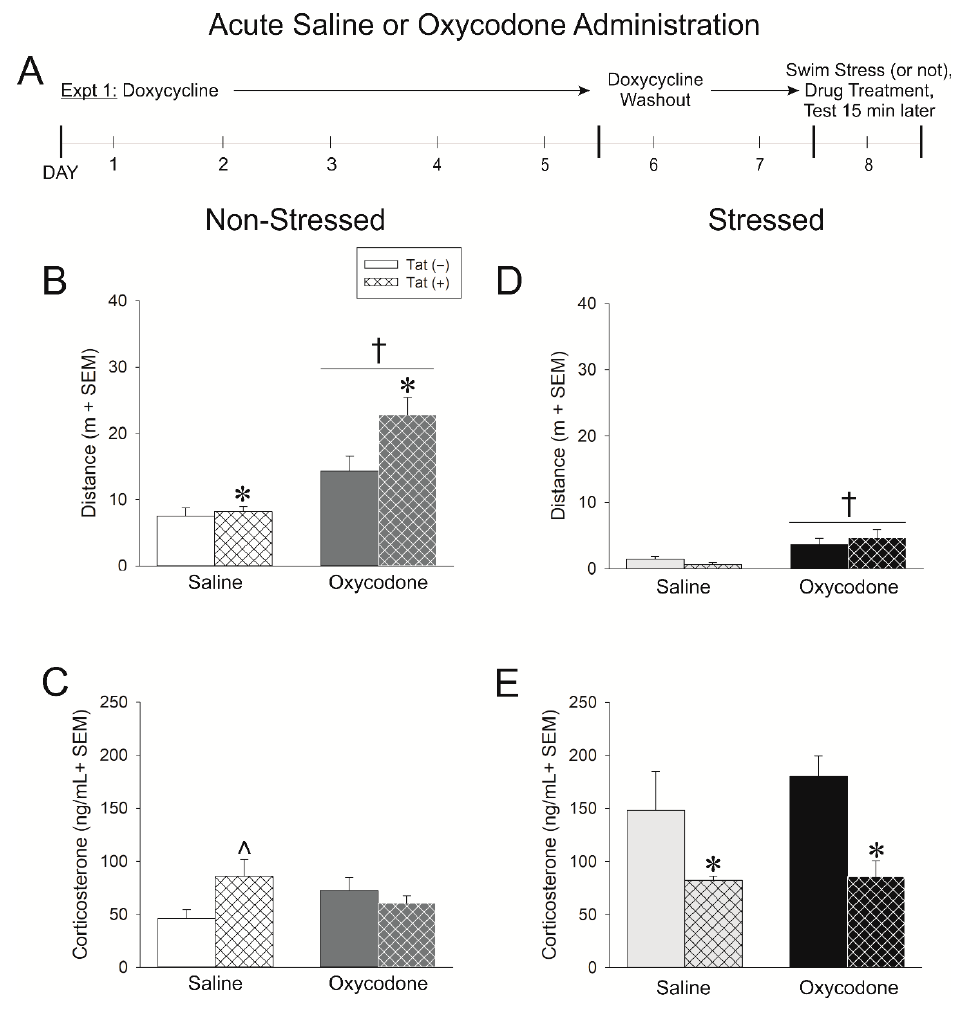
Figure 1. ( A ) In experiment 1, human immunodeficiency virus (HIV)-1 trans-activator of transcription (Tat) expression was induced in Tat(+) males (hatched bars), or not induced in Tat( − ) controls (open bars), via administration of doxycycline (30 mg/kg, i.p., once daily for 5 days with 2 days of washout). Mice were either stressed via forced swim for 15 min (panels D and E) or not (panels B and C) and acutely-administered saline or oxycodone (3 mg/kg, i.p.) 15 min prior to assessment in an open field and light-dark transition test ( n = 8–12/group). ( B ) Distance (m) traveled in an open field and ( C ) circulating corticosterone among non-stressed mice. ( D ) Distance (m) traveled in an open field and ( E ) circulating corticosterone among stressed mice. * indicates a main effect of genotype wherein Tat(+) mice di ff er from Tat( − ) controls. † indicates a main e ff ect for oxycodone to di ff er from saline-administered mice. ˄ indicates an interaction wherein saline-administered Tat(+) mice differ from respective Tat( − ) controls, p < 0.05.